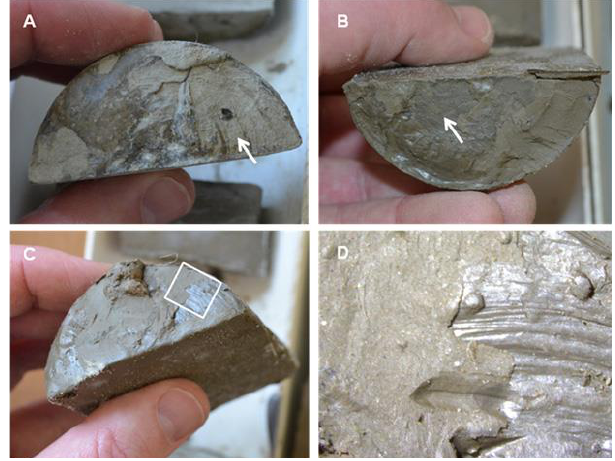
Figure 6. Concentric grooves in various parts of the Wilson Lake B core, as seen in half-round specimens from the archive half. (a) Top of a core disc with patches of adhering injected slurry and concen- tric grooves (highlighted with arrow). (b) Base of a core disc with patches of adhering injected slurry and concentric grooves (high- lighted with arrow). (c) Top of a core disc with patches of adher- ing injected slurry and concentric grooves. (d) Microscopic detail of highlighted area in (c) showing a patch of remaining slurry (to the left) unconformably overlying the surface of a core disc which shows concentric grooves. Similar observations were made at other levels in the core.